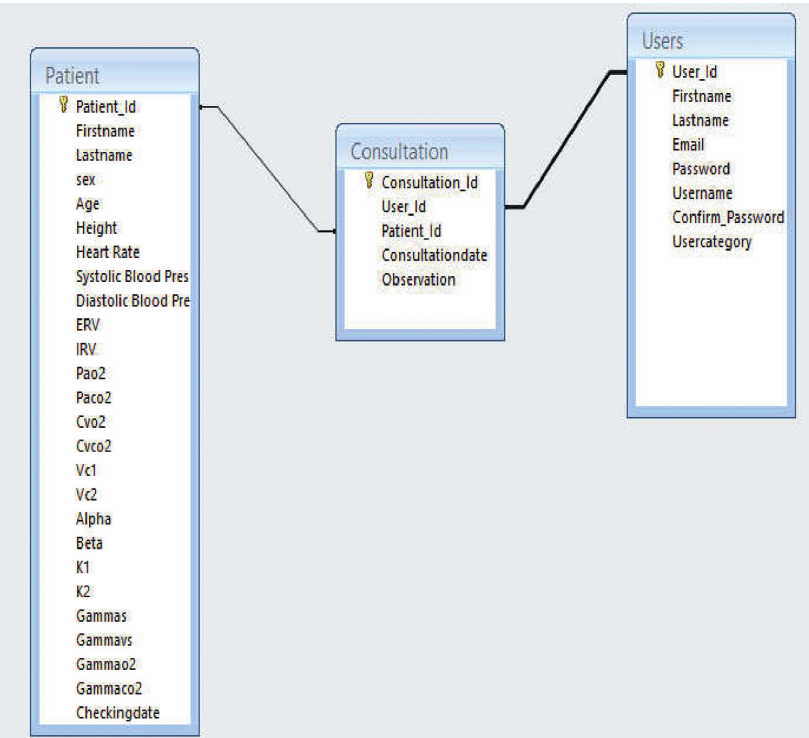
Figure 5: Entity relationship diagram of ICRSMM